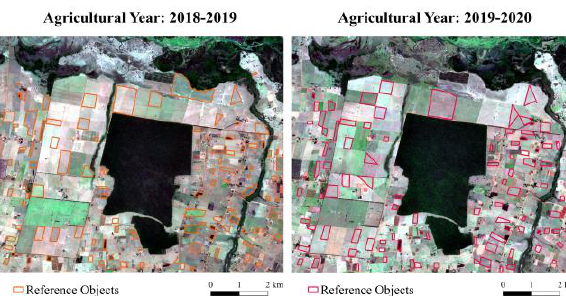
Figure 4 . Handly digitised reference objects representing agricultural fields with a uniform spectro-temporal pattern, considering each of the agricultural years under